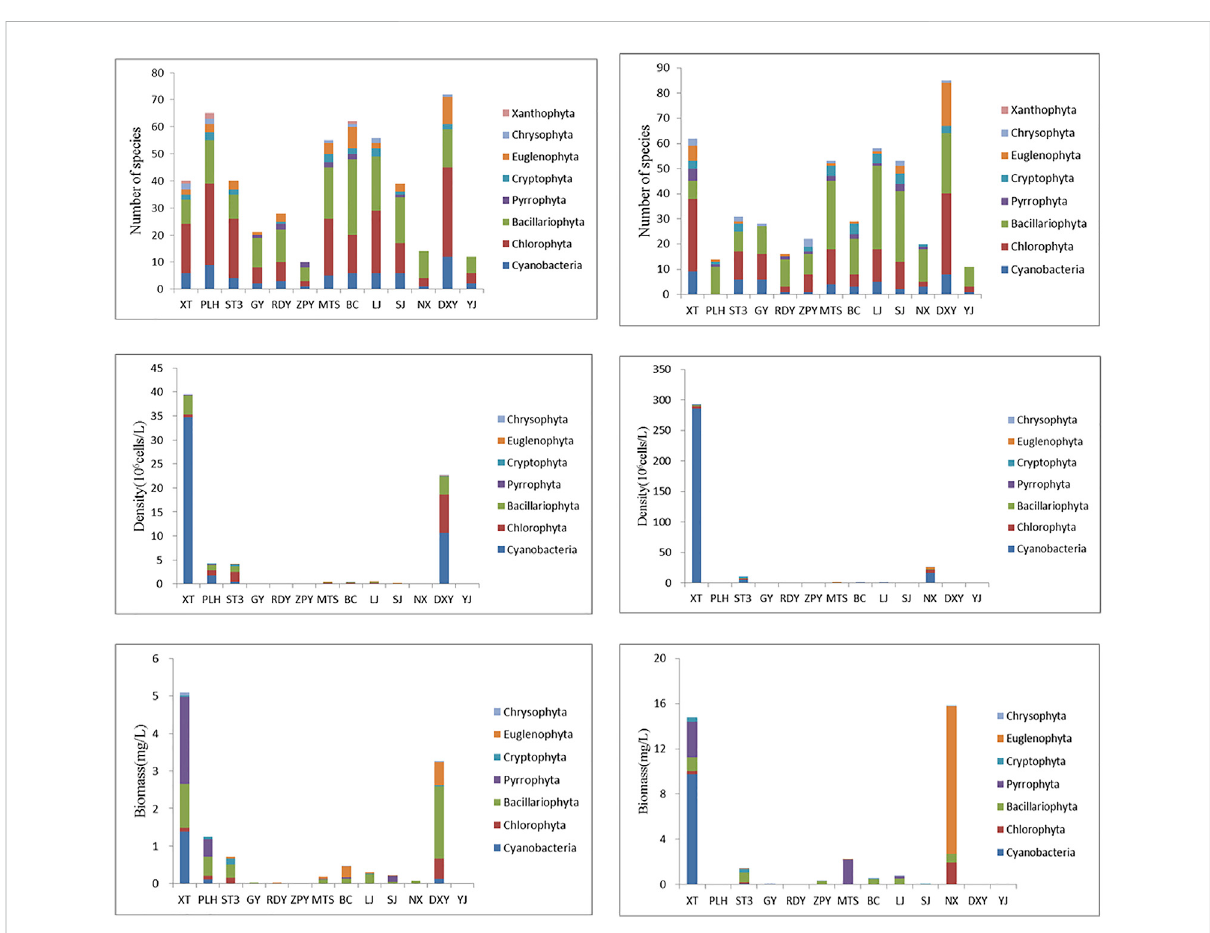
FIGURE 4 Phytoplankton community composition of each sampling sites. The left column was the results in May and the right column was results in November.